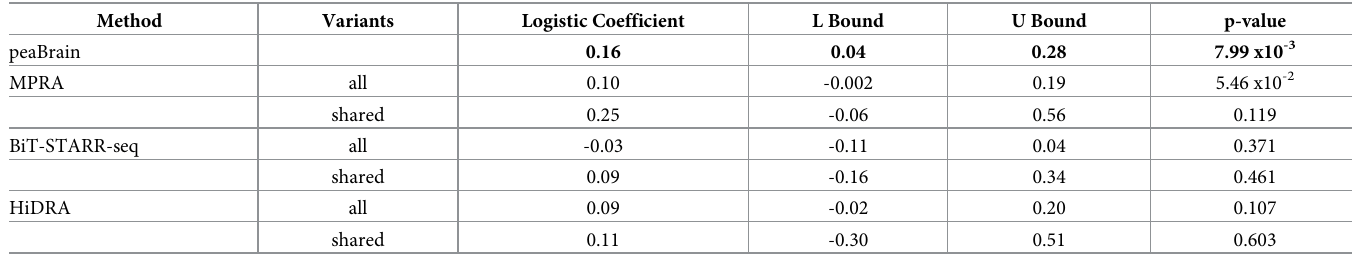
Table 3. In the 113 “captured” genes, peaBrain estimates can significantly delineate variants with established regulatory function (Task H).